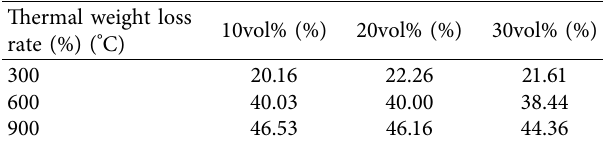
Table 3: Thermal weight loss rate of HPM/phenolic syntactic foam at different temperatures. Thermal weight